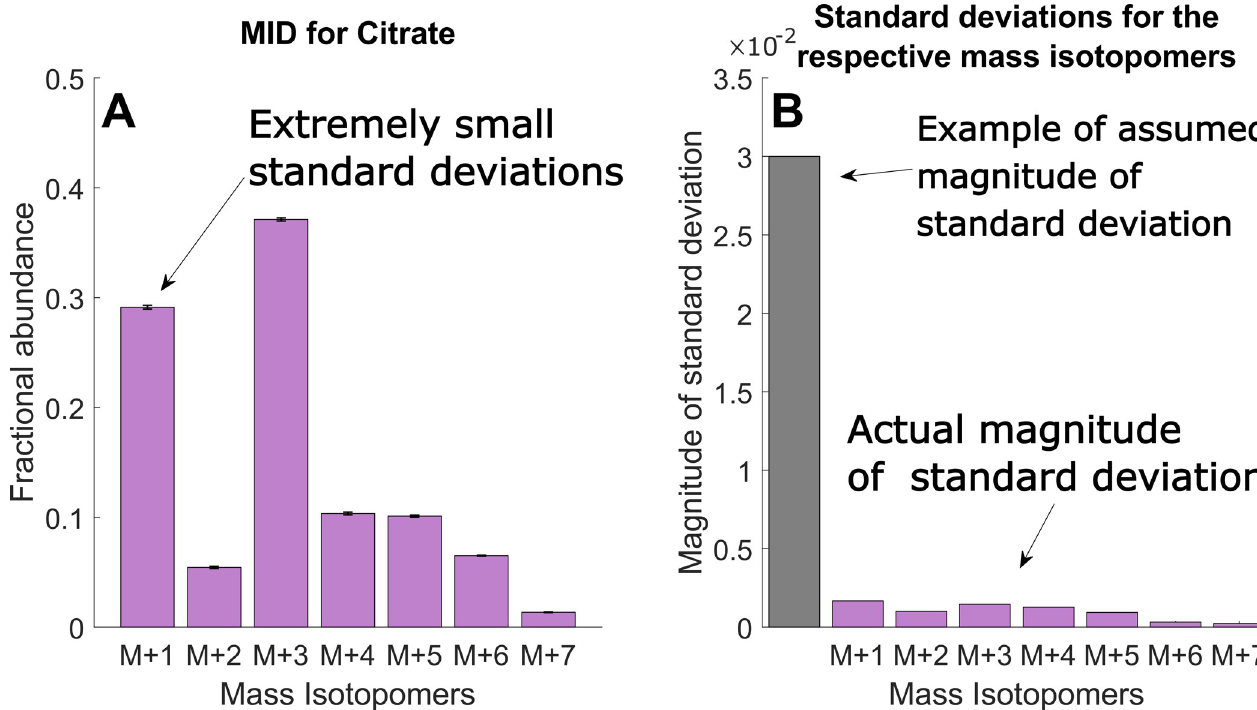
Fig 2. Example of MID sample standard deviation (A) Example of estimated mass isotopomer distribution (MID) of citrate from epithelial cells, as described in section 2.5. M+i indicate the fractional abundance of the i:th mass isotopomer. (B) Difference between the assumed magnitude of the standard deviations and the measured